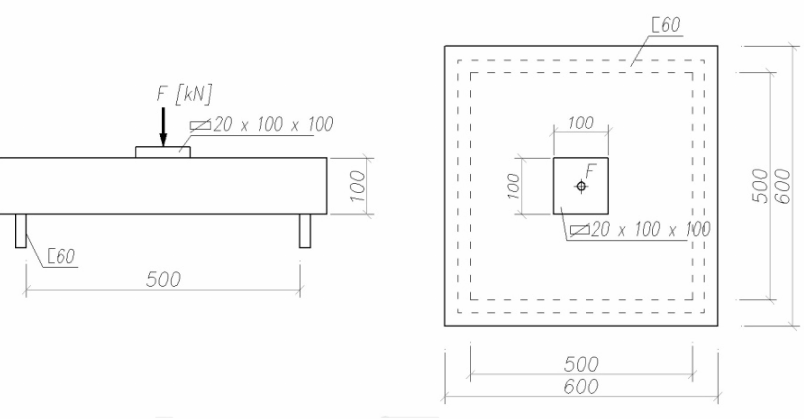
Figure 5. The scheme of the slab loading in the study of the energy absorption capacity of a fiber composite, recommended by [35].